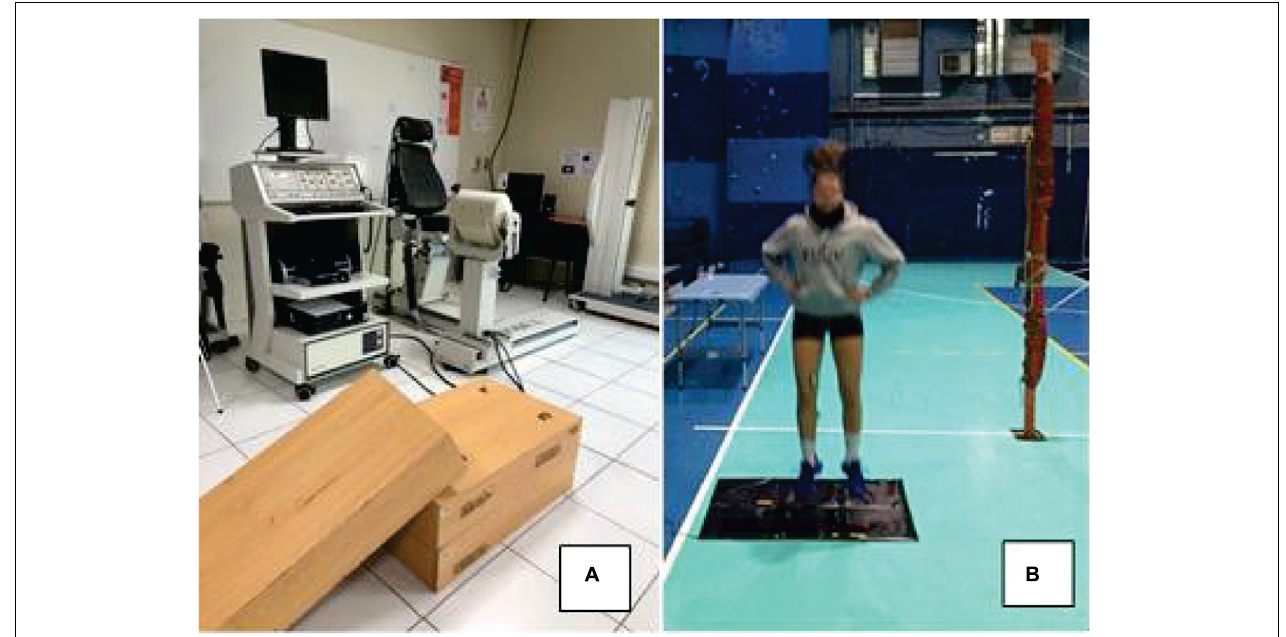
FIGURE 1 | Setup used to evaluate the participants in the study. (A) Isokinetic for maximal voluntary isometric contraction and boxes (i.e., 15 cm height each) used during drop jumps and (B) contact mat, with participant warming up before